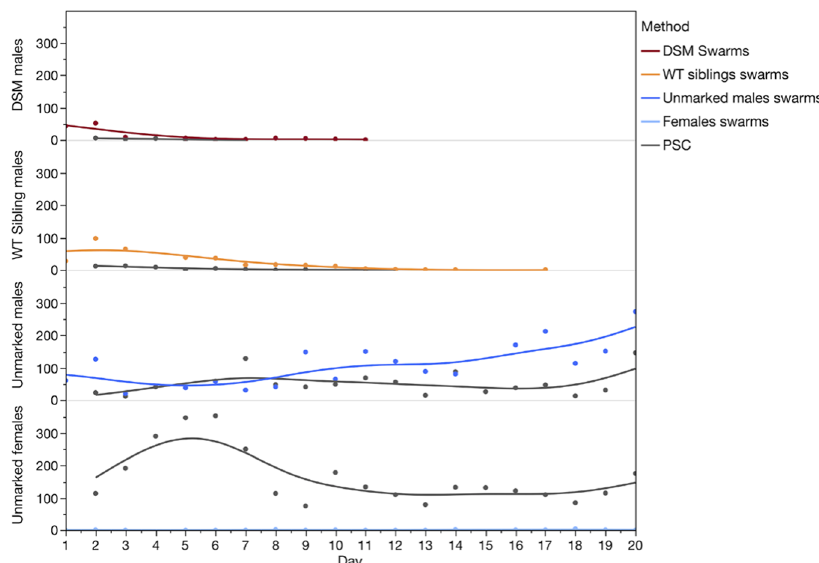
Fig. 2 Daily recapture of marked males and unmarked male and female mosquitoes in relation to genotype and the collection methods (swarm collection and PSC). The number of marked males of both genotypes decreased quickly over time and no Ac(DSM)2 were recaptured beyond day 11. (DSM: Dominant Sterile Male; WT: Wild type; PSC: Pesticides Spray Catches).